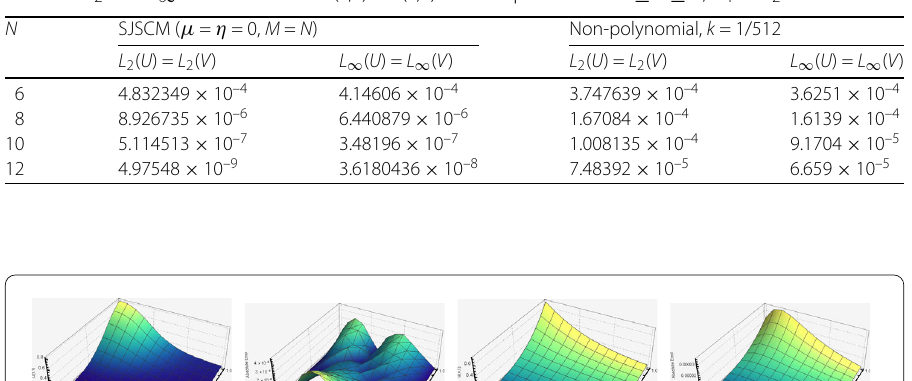
Table 6 L 2 and L ∞ error norms for u ( x , t ) = v ( x , t ) of Example 1 when 0 ≤ x ≤ 3, α 1 = α 2 = 0.6